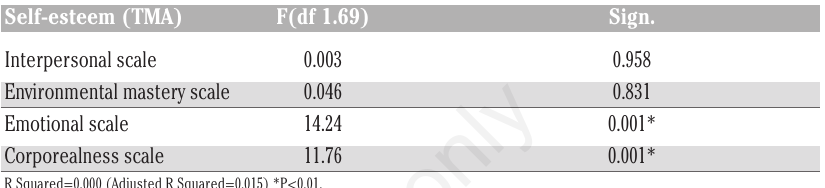
Table 2. The TMA ( test multidimensionale dell'autostima ) scores: differences between the experimental group (N=40) and the control group (N=30).